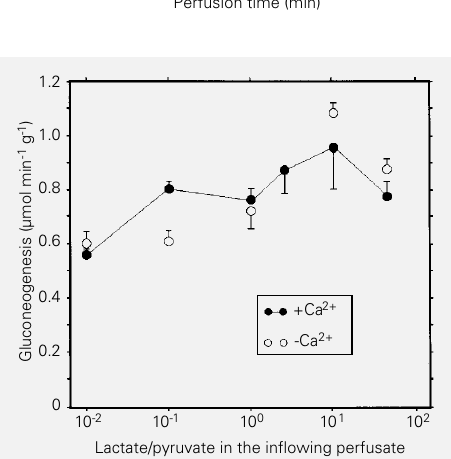
Figure 1 - Time course of the effects of glucagon on glucose production, oxygen uptake and pyruvate production. Livers from fasted rats were perfused with Krebs/Henseleit-bicarbonate buffer containing 2.5 mM CaCl 2 , as described in Material and Methods. Lactate plus pyruvate (3.4 and 0.35 mM, respectively) and glucagon (10 nM) were in- fused as indicated by the hori- zontal bars. Samples of the outflowing perfusate were taken at 2-min intervals and glucose and pyruvate were measured en- zymatically. Oxygen uptake was followed polarographically. Each data point represents the mean of 3 liver perfusion experiments.